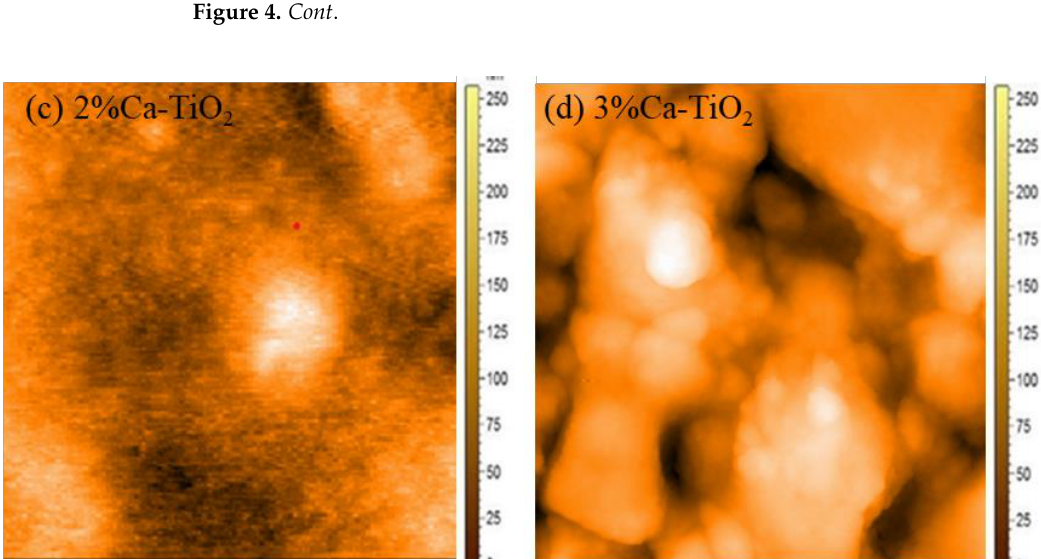
Figure 4. AFM images of ( a ) TiO 2 , ( b ) 1% Ca-TiO 2 , ( c ) 2% Ca-TiO 2 , and ( d ) 3% Ca-TiO 2.